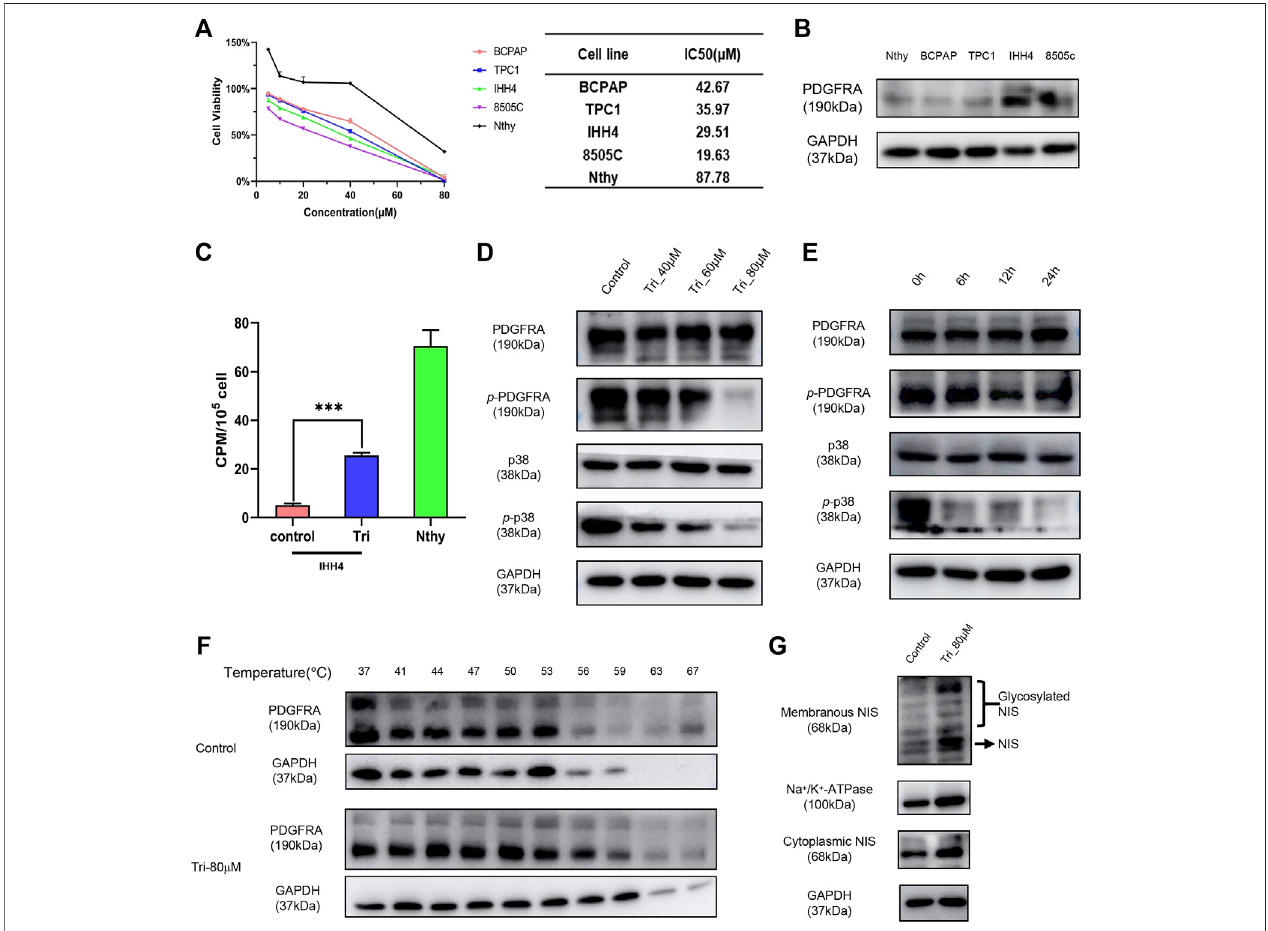
FIGURE6| BiologicalvalidationofthevirtuallyscreenedPDGFRAinhibitors. (A) Theeffectof4 ’ ,5,7-trimethoxy fl avoneontheviabilityofthyroidcarcinomacellsand normal thyroid cells. (B) The expression of PDGFRA in thyroid carcinoma cells and normal thyroid cells. (C) The effect of 4 ’ ,5,7-trimethoxy fl avone on radioiodine uptake capacity of IHH4 cell line. (D,E) The effect of 4 ’ ,5,7-trimethoxy fl avone on protein expression of p-PDGFRA and p-p38. (F) The binding of 4 ’ ,5,7-trimethoxy fl avone to PDGFRA was examined by the CETSA test. (G) The effect of 4 ’ ,5,7-trimethoxy fl avone on expression and cellular location of NIS. ***, p < 0.001, compared with control group. Nthy: Nthy-ori-3-1 cell line; Tri: 4 ’ ,5,7-trimethoxy fl avone; p-PDGFRA: phospho-PDGFRA (Tyr754); p-p38: phospho-p38 MAPK (Tyr 182).